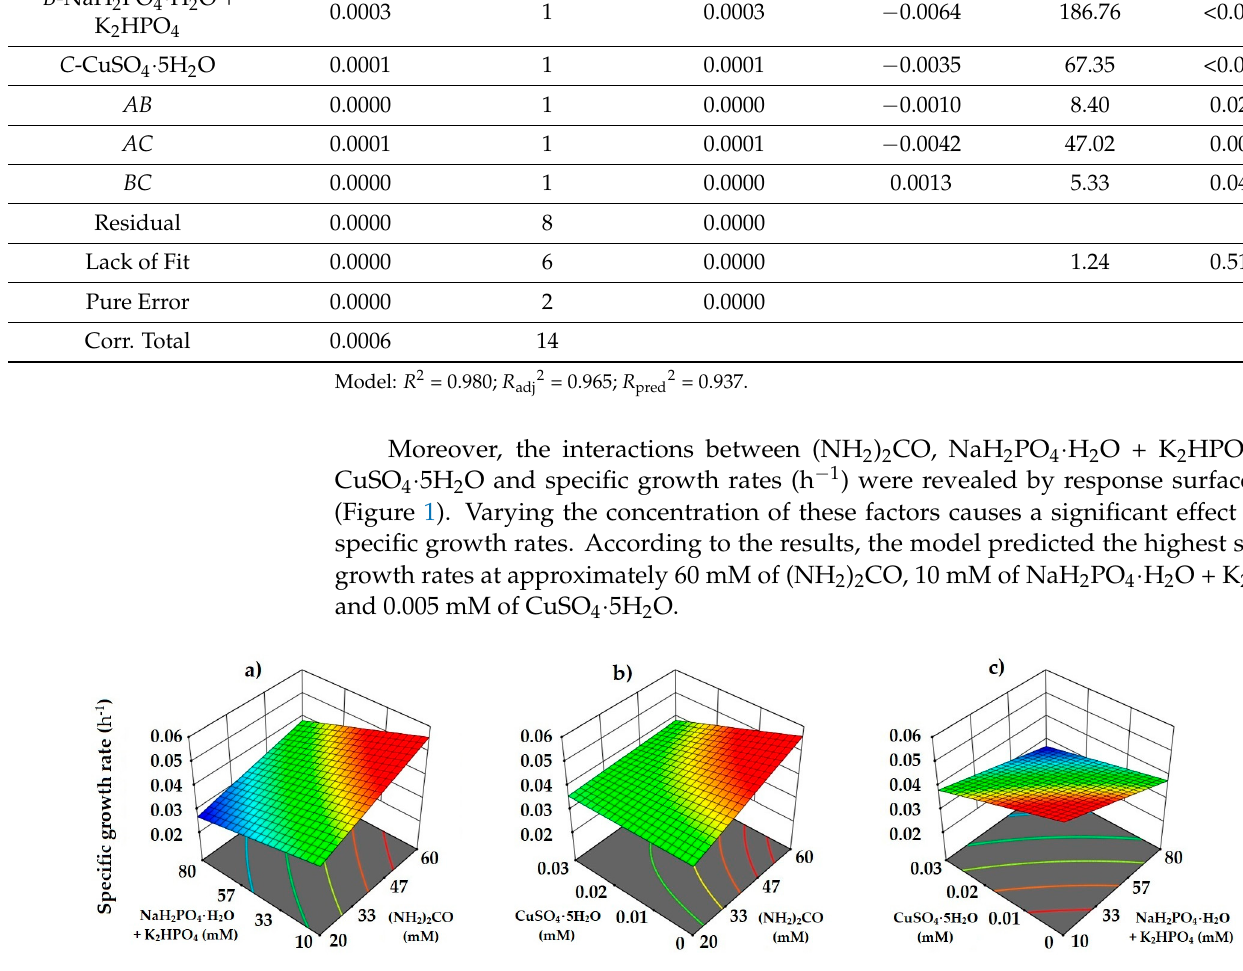
Figure 1. Response surface plots showing the interactions effects of ( a ) (NH 2 ) 2 CO and